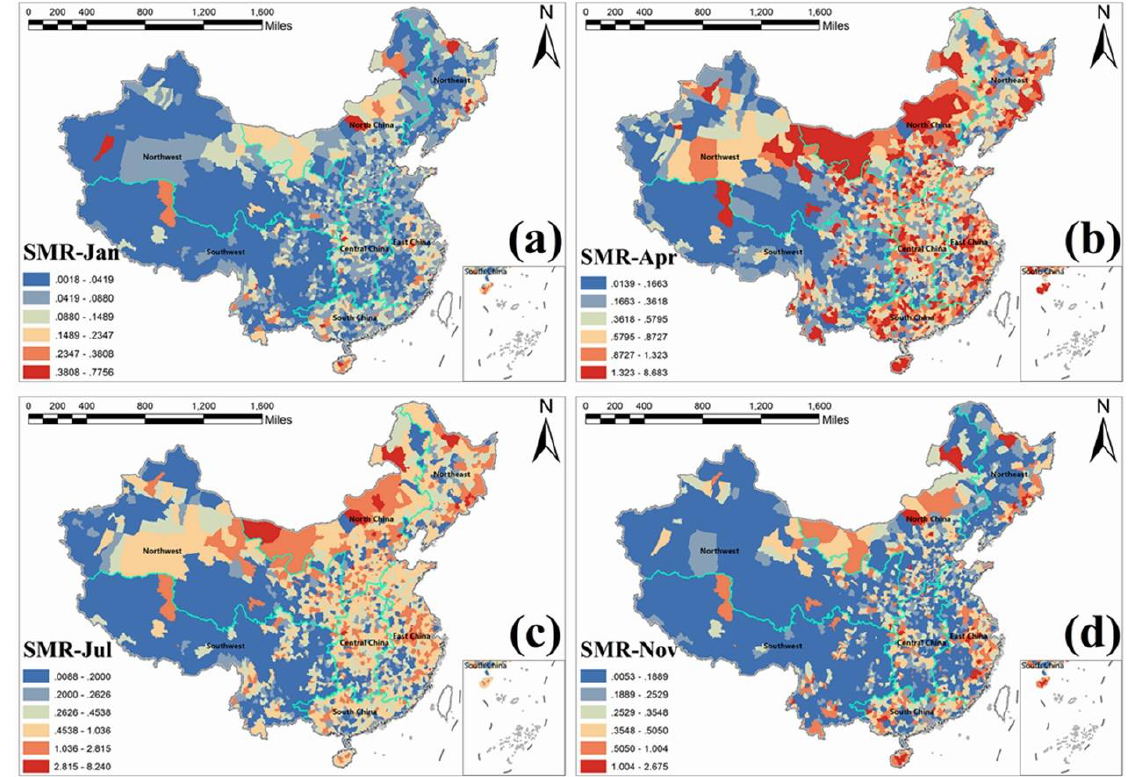
Figure 4. Estimated standard morbidity ratio (SMR) maps of HFMD incidence at county-level in Mainland China in 2009; ( a ) January, ( b ) April, ( c ) July, and ( d ) November.